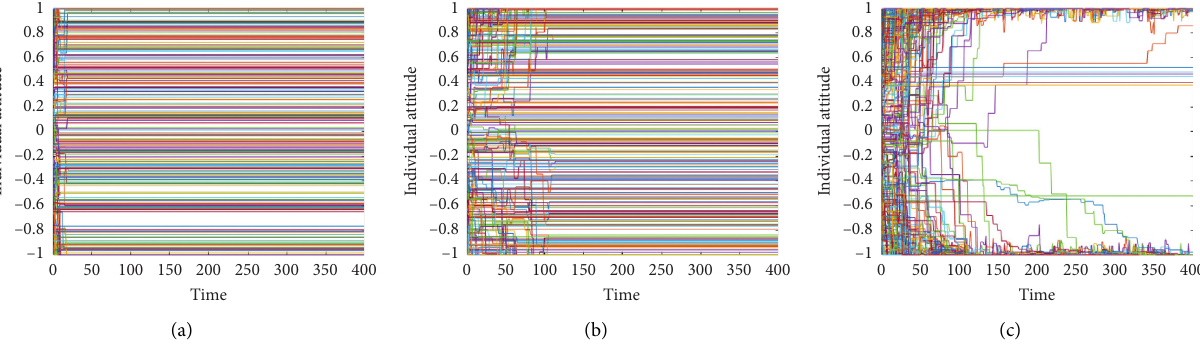
Figure 13: Attitude polarization evolution with immune recovery rate of 0.1, 0.3, and 0.5. (a) c � 0.1. (b) c � 0.3. (c) c �